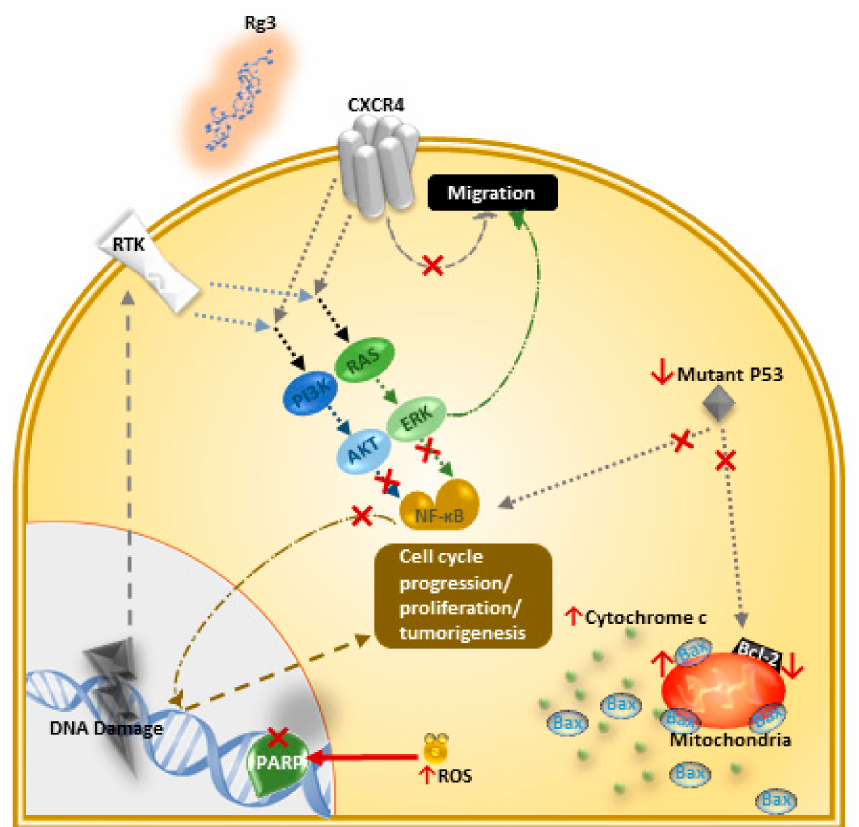
Figure 3. Rg3 inhibits cell proliferation and induces apoptosis via different effector molecules and pathways, in MDA-MB-231 cell line [30,31]. Changes in specific molecules involved in signalling pathways upon exposure of the cells to Rg3 is shown in this figure. The ↑ and ↓ arrows are indicating increased and decreased levels of certain molecules, respectively, and the × signs show the inhibition of a signalling pathway or function of a certain protein in the MDA-MB-231 cell